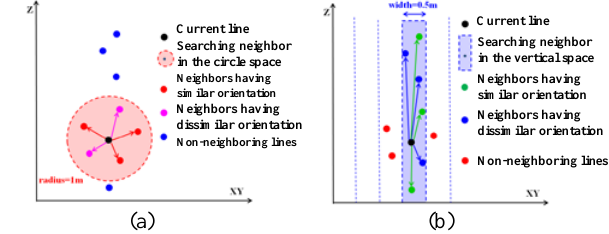
Figure 2. Neighborhood selection for context